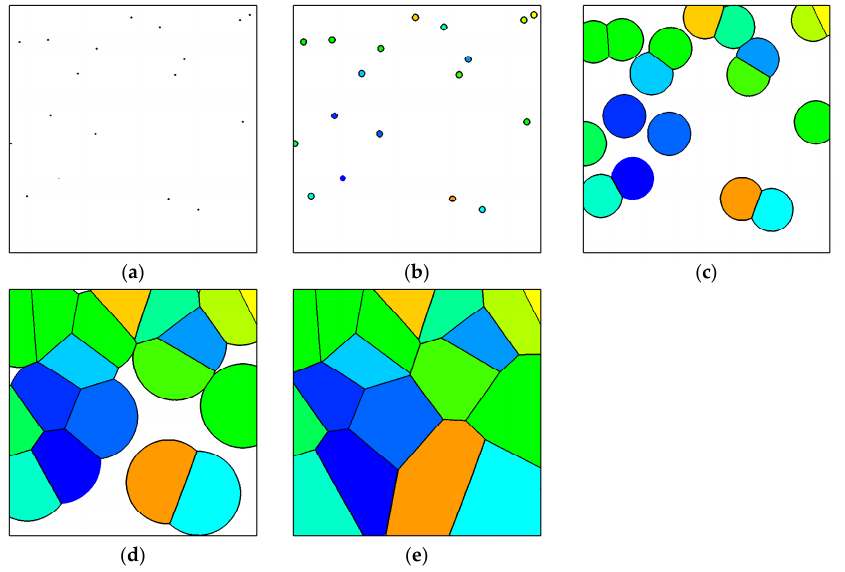
Figure 6. Examples of spherulitic morphology obtained from the stochastic simulation scheme at T = 106.85 °C : ( a ) t = 0 s; ( b ) t = 6.8 s; ( c ) t = 50.3 s; ( d ) t = 98.7 s; and ( e ) final morphology.